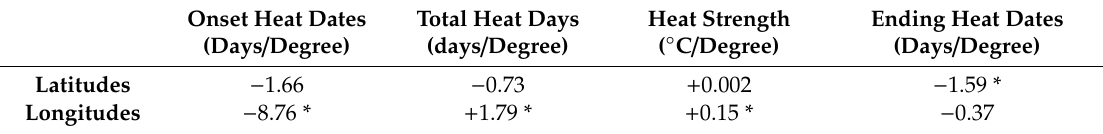
Table 2. The regression coe ffi cients of onset heat dates, total heat days, heat strength, and ending heat dates with the latitudes and the longitudes.